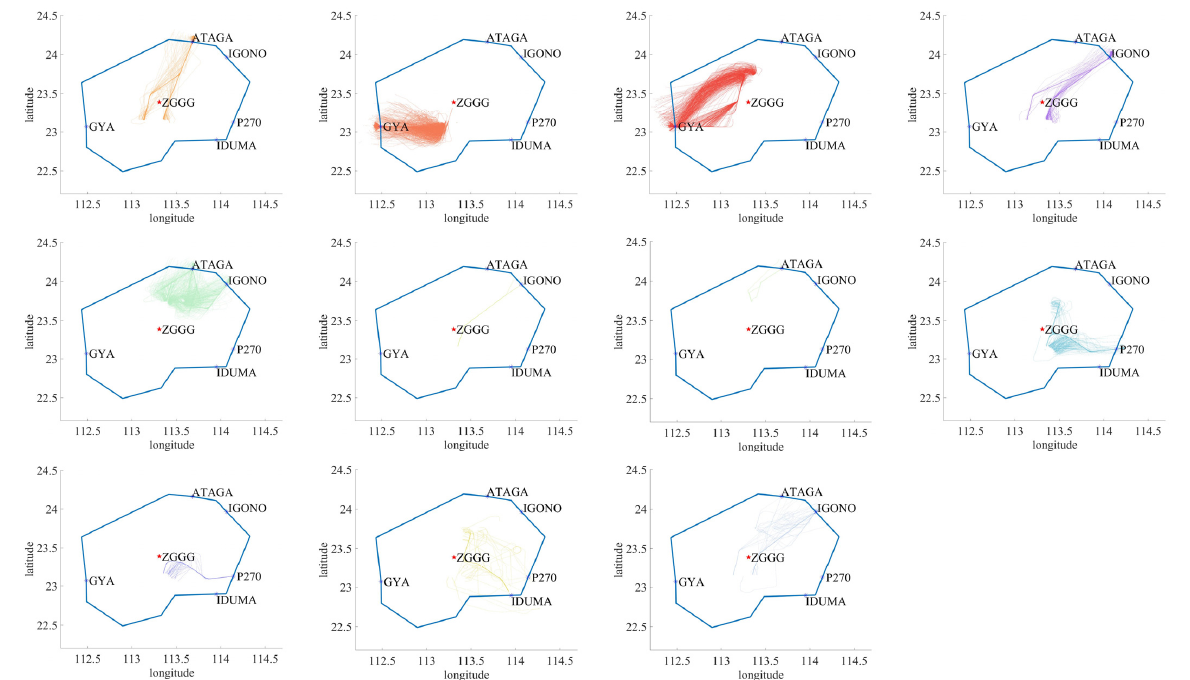
Figure 11. Clustering results of flight trajectories of ZHHH (K-Means).